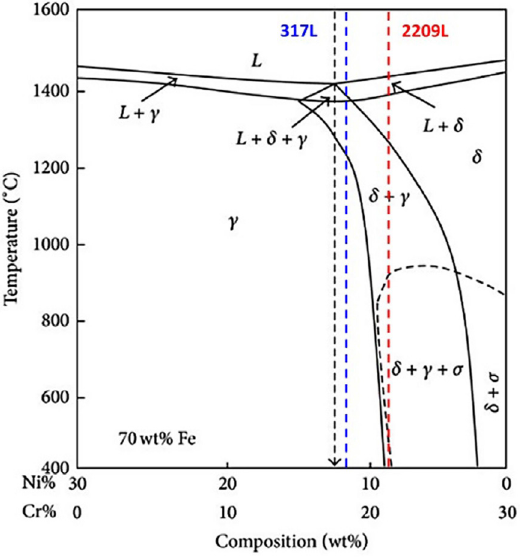
Figure 5. Fe-Cr-Ni pseudo-binary diagram